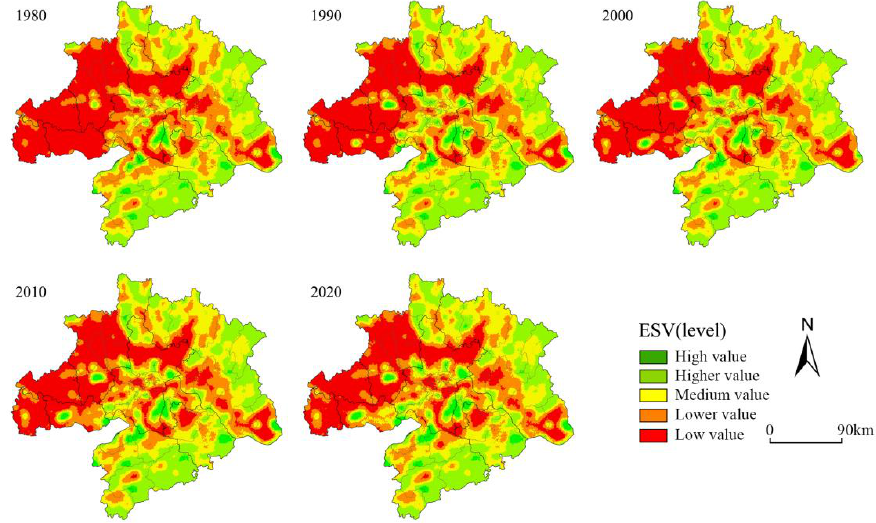
Figure 6. Change in ecosystem service value from 1980 to 2020.